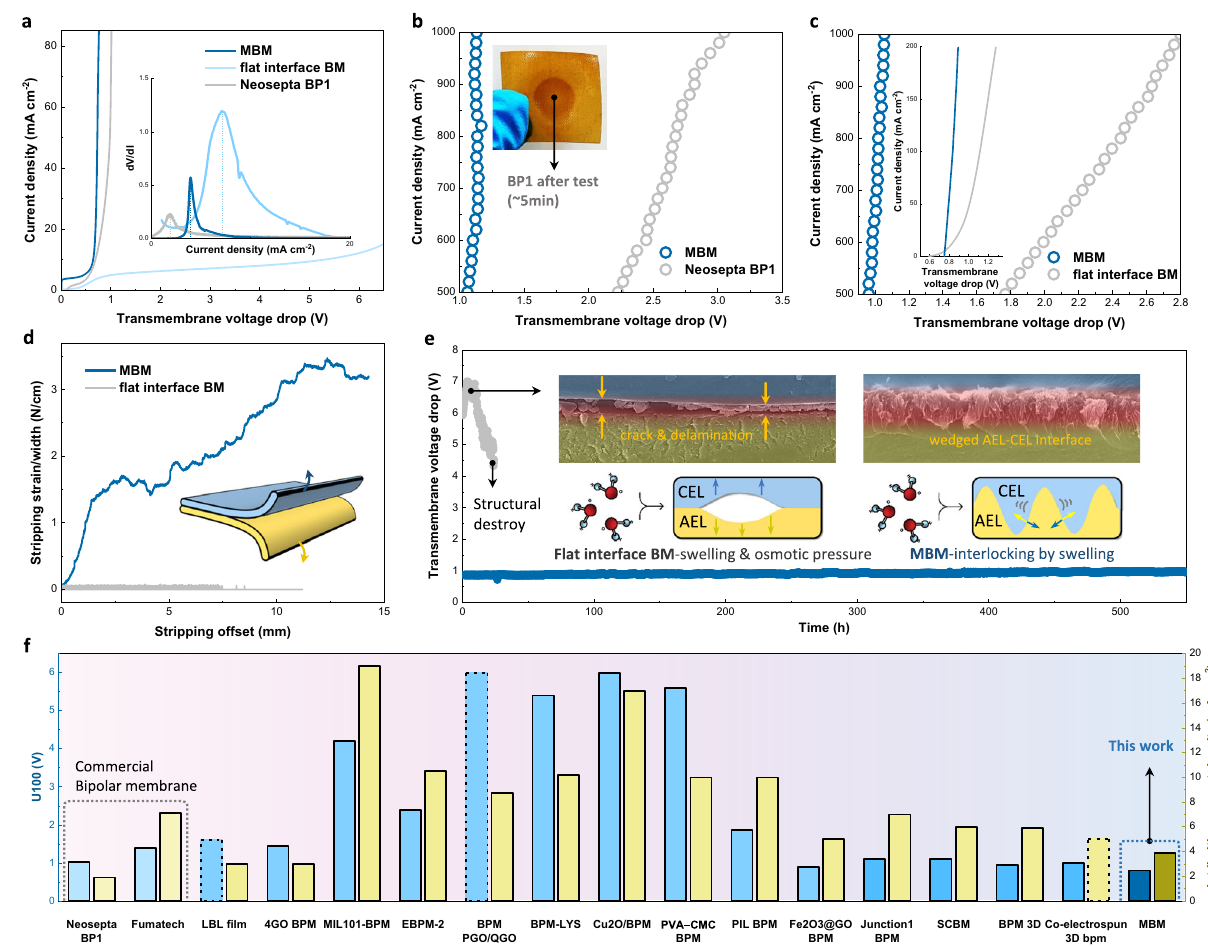
Fig. 4 | WD performance characterization and stability of BMs. Comparison of I – V curves for three BMs in a low current density and b high current density, measured in 0.5M Na 2 SO 4 aqueous solutions with a scan rate of 2mAs − 1 . Inset of a showsdetermination1stlimitingcurrentdensity.Insetof b showsphotographyof BP1 image afterone I – V cycle from 0to 1000mAcm − 2 . c Comparison of I – V curves for BMs up to 1000mAcm − 2 (inset is I – V curve in low current density) using unsymmetrical1MHCl/1MKOHelectrolyteswithascanrateof2mAs − 1 . d Physical stripping strain of AEL – CEL of bipolar membranes in wet state versus offset